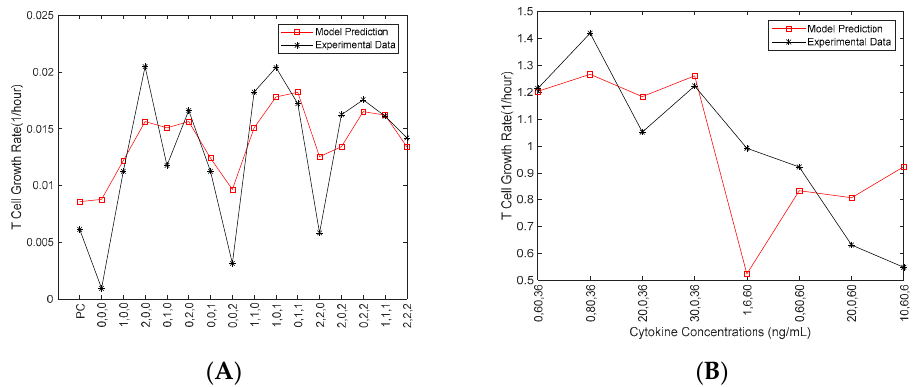
Figure 2. Fuzzy model prediction with experimental data from September ( A ); Fuzzy Model prediction with experimental data from October ( B ). Experimental data in ( A ) is from a single dataset used to estimate parameters for the fuzzy model, and model predictions in ( B ) were tested in a second experimental run to validate the model predictions and analyze the choice of cytokine concentrations for future experiments. MATLAB was used for these modeling studies.